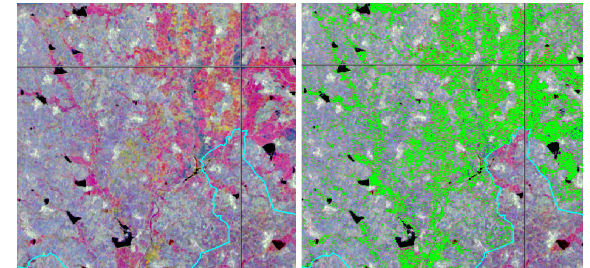
Figure 12: Sentinel-1 Multi temporal image (2017) (left) and classified (right) parts of Khammam district of Figure 9. Coefficient of determination for area, yield and production